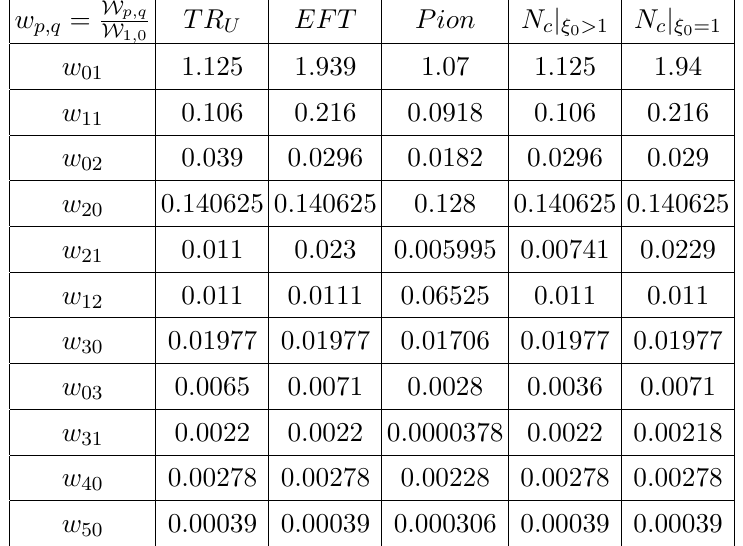
Table 2. A comparison of maximum values obtained using our results with [8, 34] and Locality constraints N for ξ = 1 and ξ 1 c 0 0 >